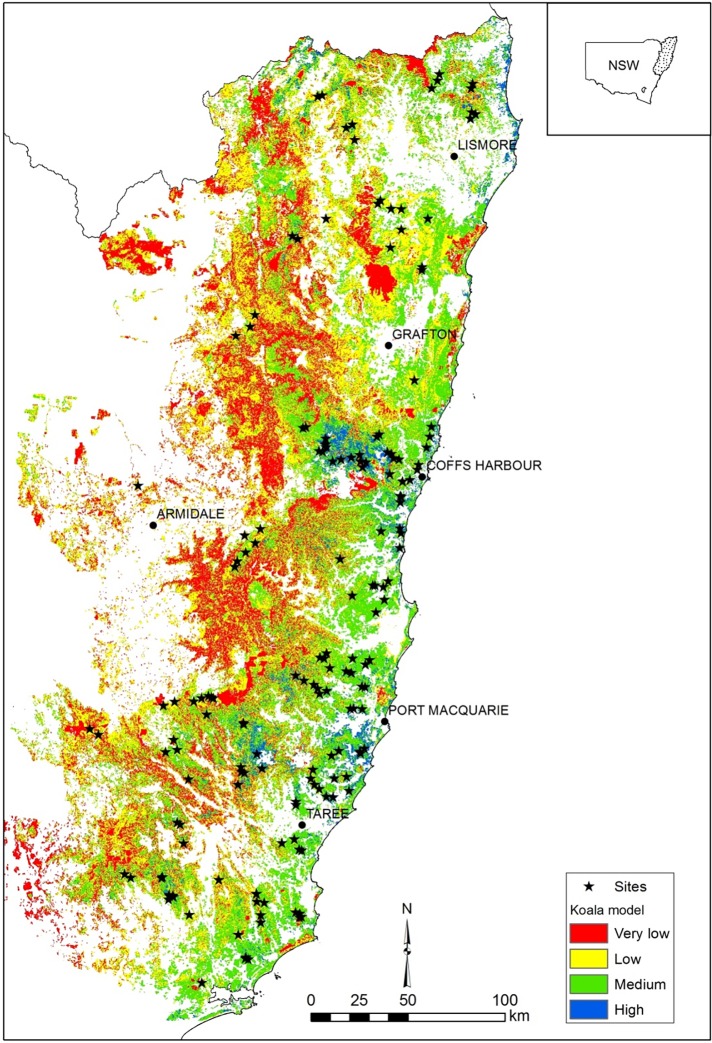
Location of 171 survey sites and distribution of modelled habitat used to target surveys in forests.